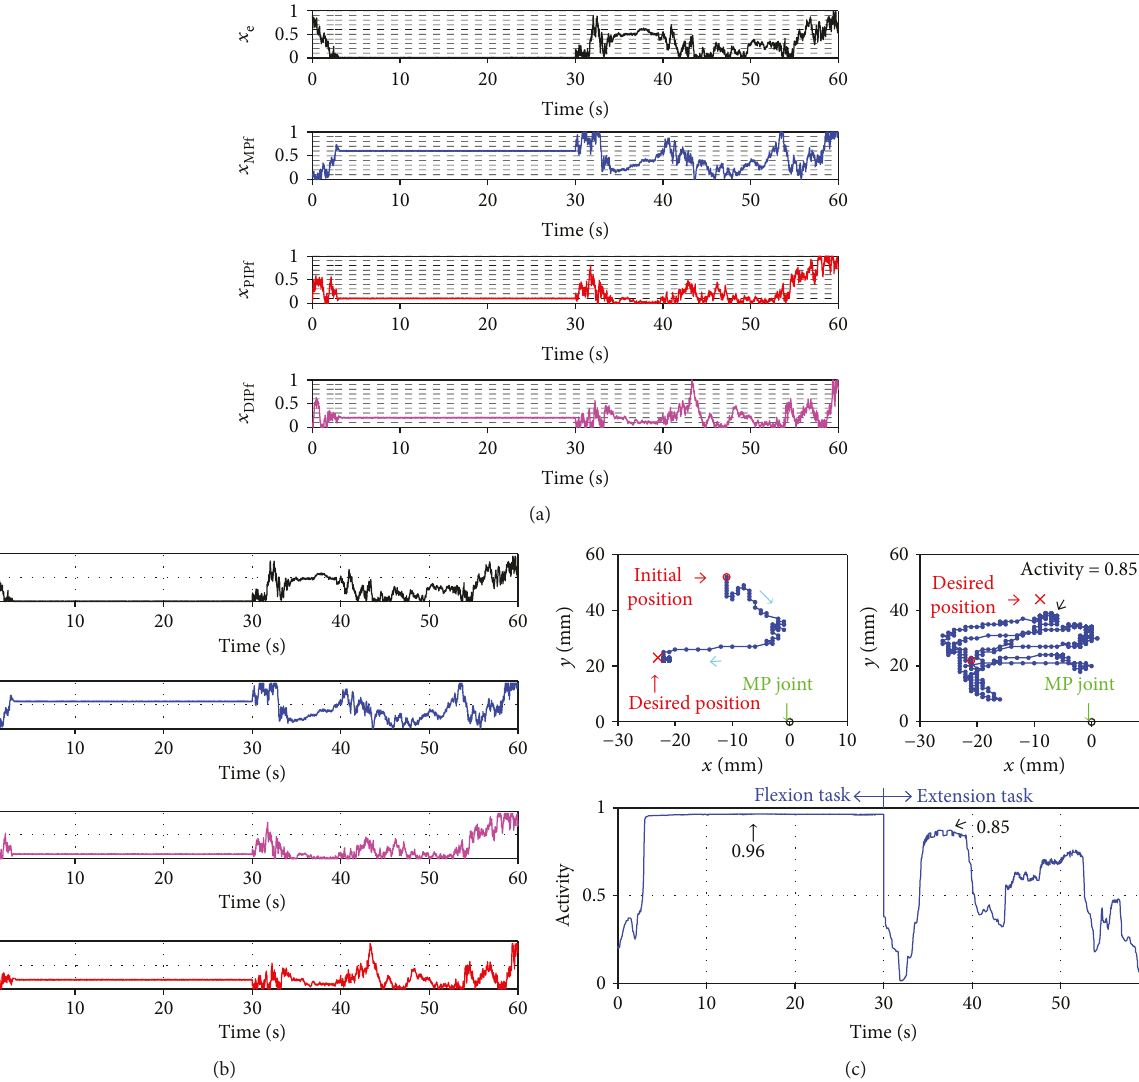
x x x e , MPf , PIPf , and DIPf ) and the